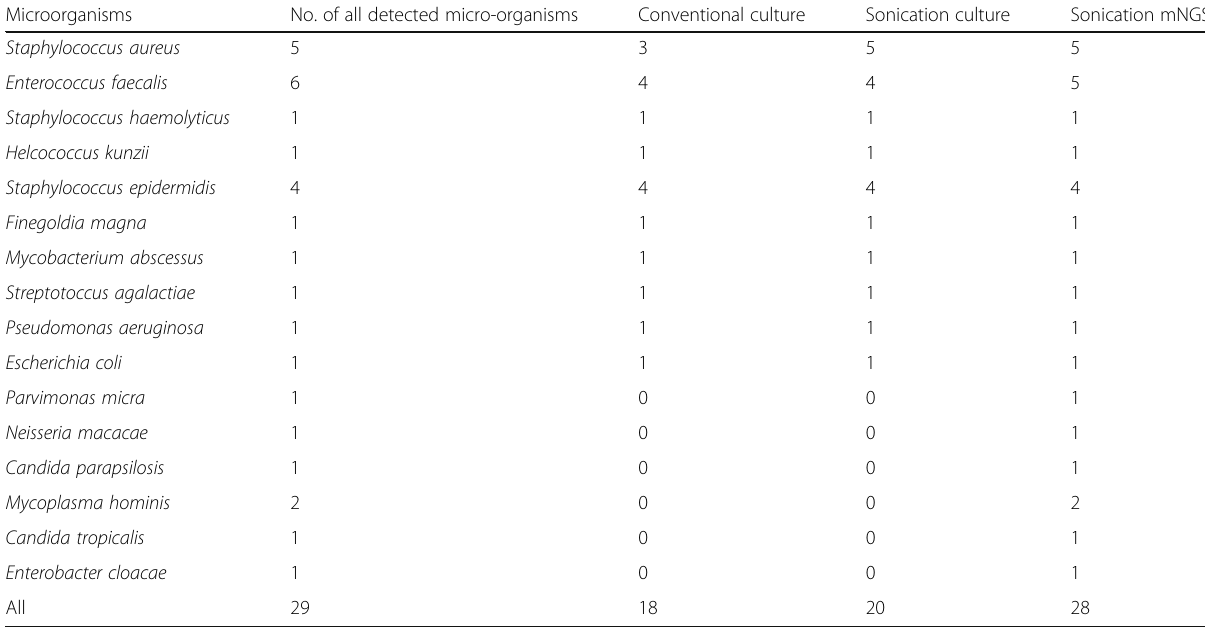
Table 2 Organisms of PJI detected by culture and mNGS Microorganisms No. of all detected micro-organisms